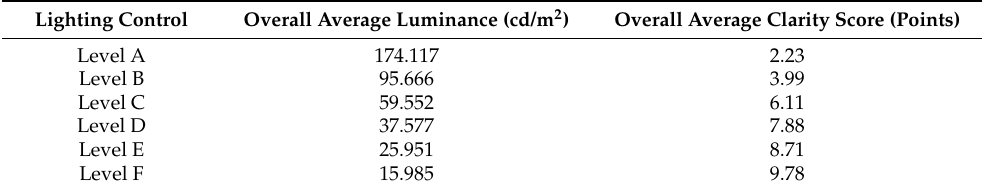
Table 5. The overall average clarity score and the overall average luminance of the case study (classroom EE-406). Lighting Control